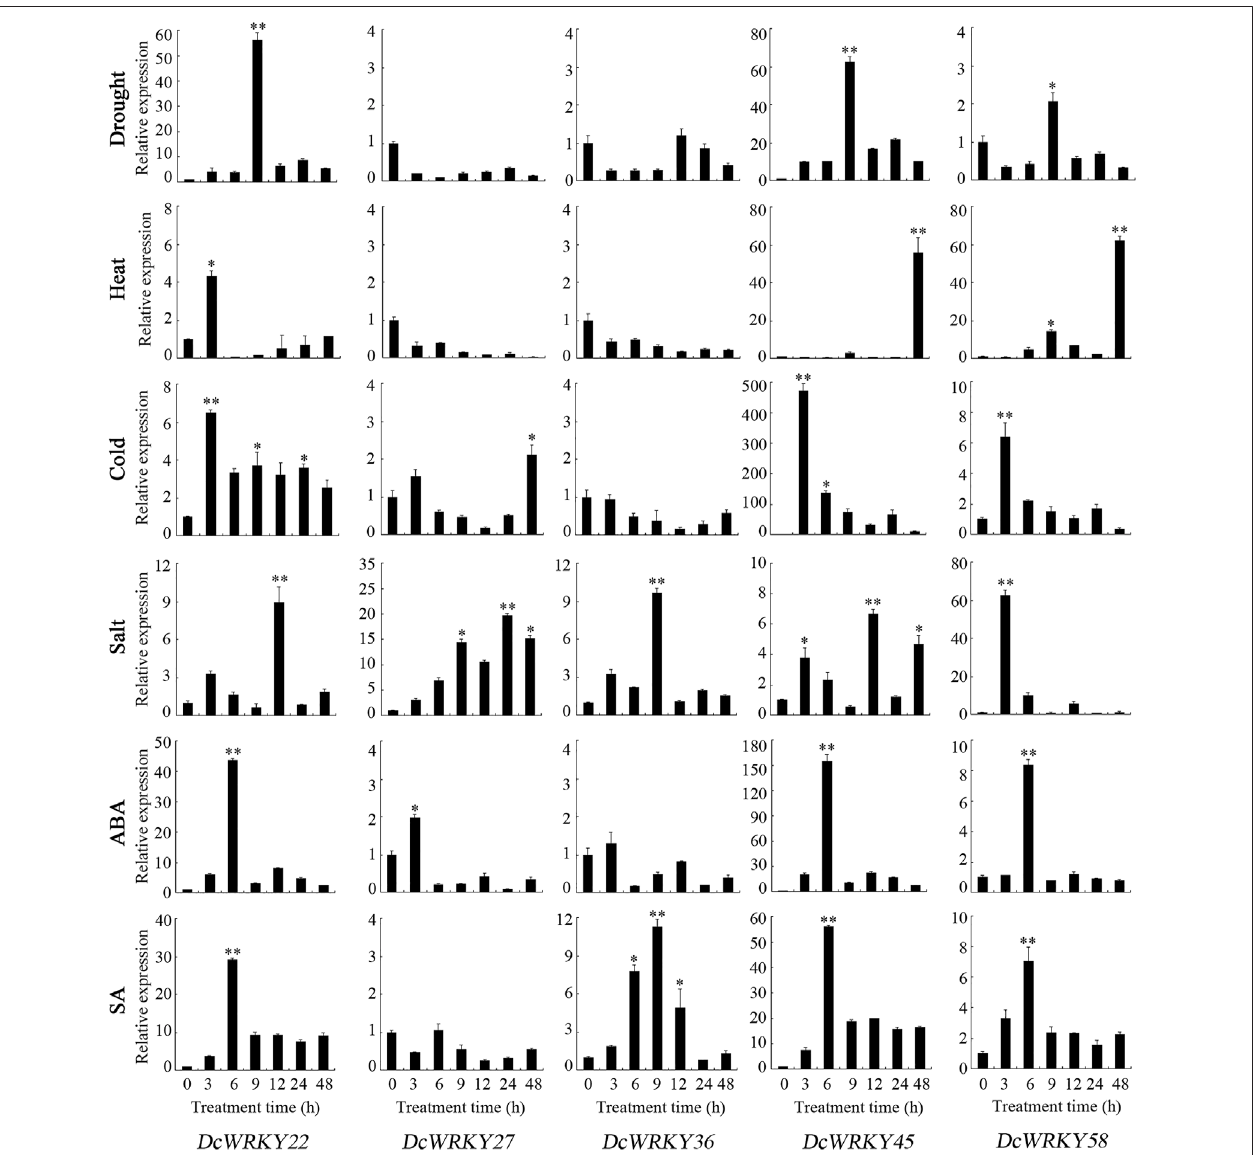
FIGURE 6 | Real-time quantitative PCR analysis of 5 DcWRKY genes under abiotic stress and hormone treatment in leaves. Vertical bars indicate the standard deviation ( n = 3). Values of 0, 3, 6, 9, 12, 24, and 48 indicate hours after treatment. The unstressed level (0 h) was used as a control. Asterisks ( p or pp ) indicate a signi fi cant difference at p < 0.05 or 0.01,